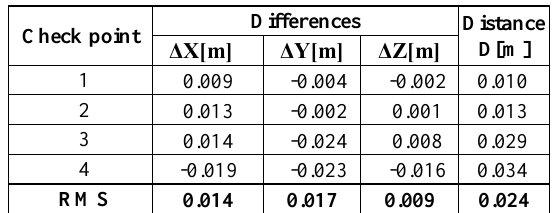
Table 2. The residuals of the artificial CPs after georeferencing